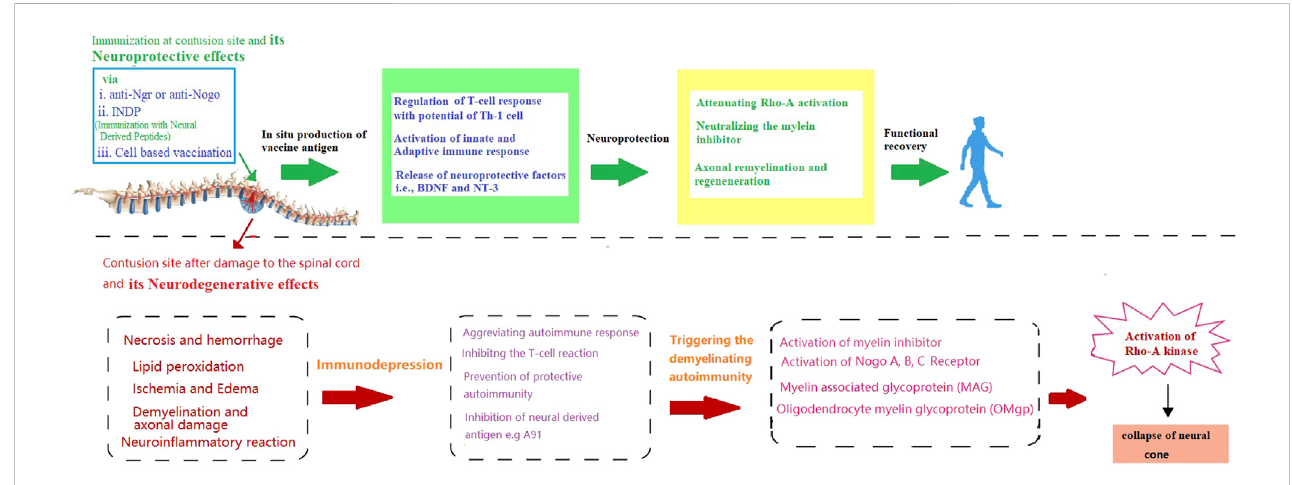
FIGURE 1 Schematic presentation of neurodegenerative effects of spinal cord injury and the possible way through immunotherapy provide neuroprotection and functional